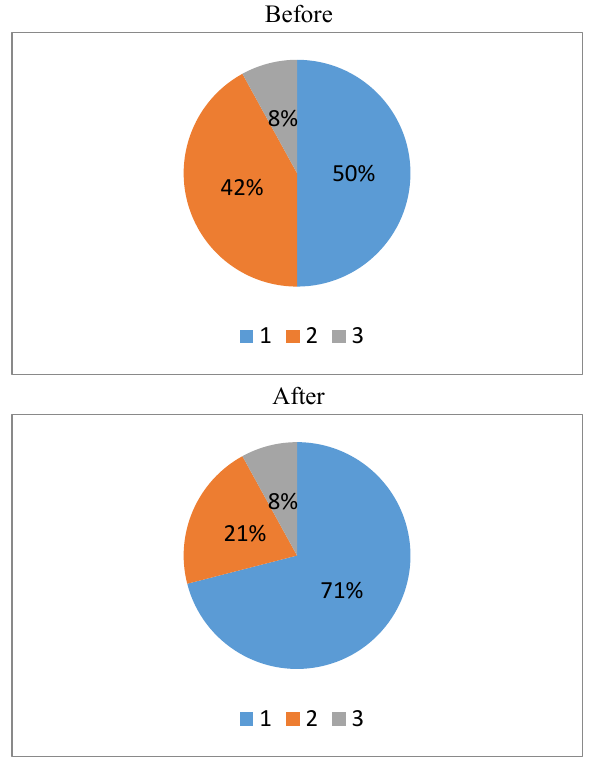
Fig.1. Distribution of children’s uniformity according to cluster